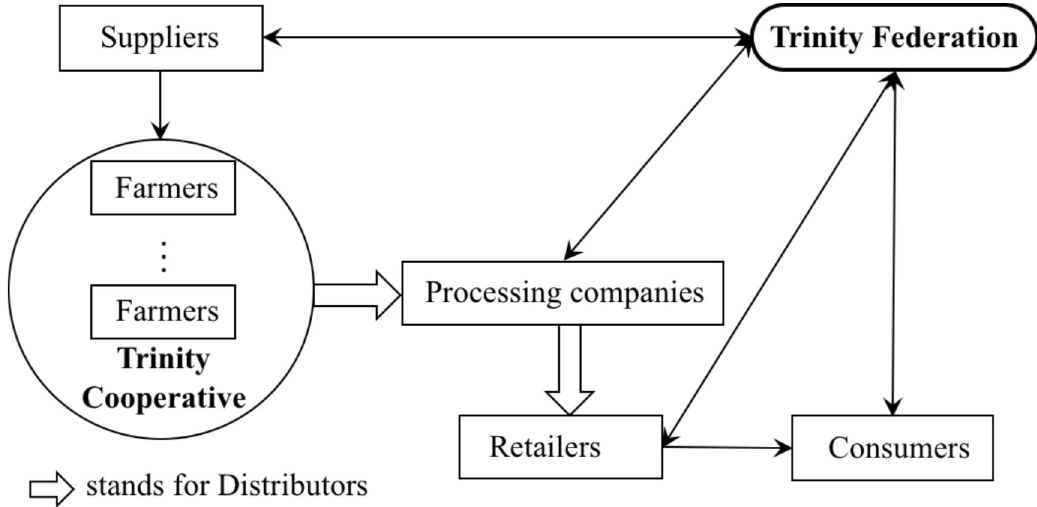
Fig 3. Framework for agricultural co-operatives in